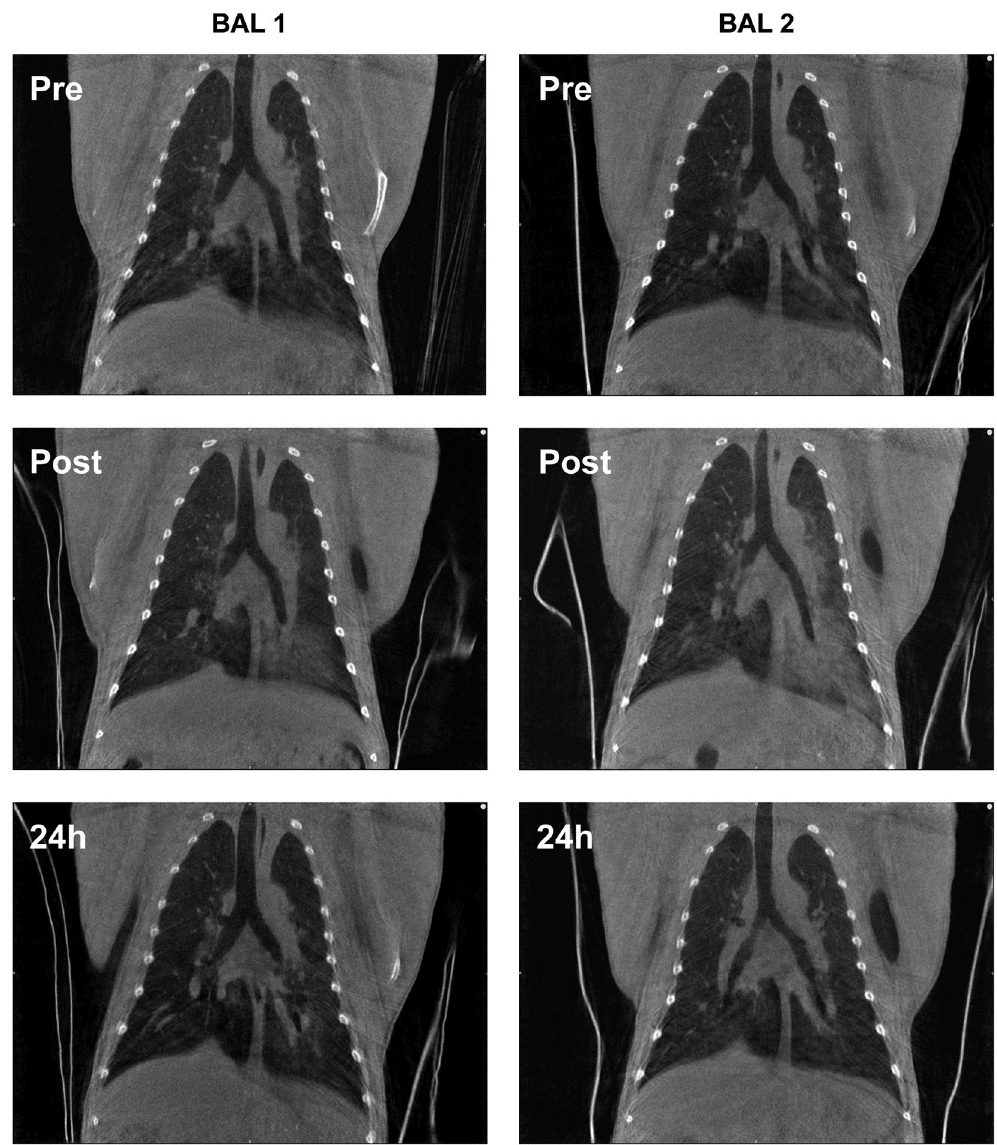
Fig 6. Representative coronal CT slices of the first and second BAL of a SARS-CoV-2 infected rhesus macaque (RM3).